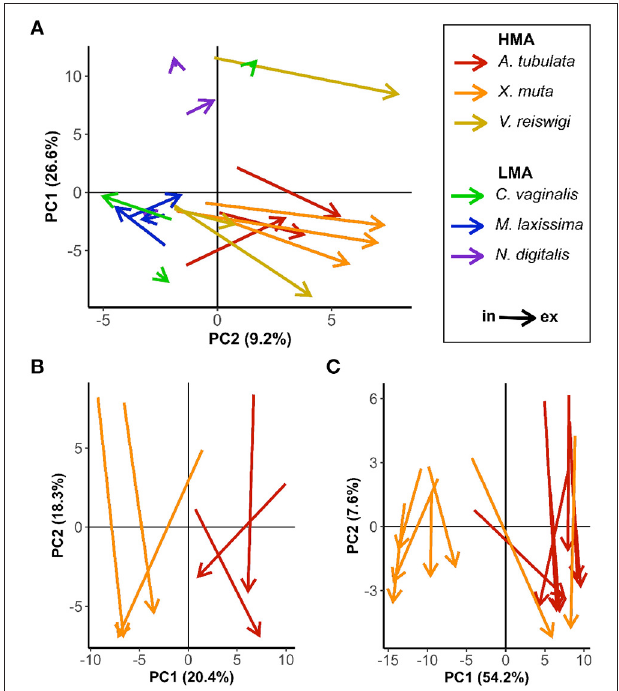
FIGURE 2 | PCA biplots of In/Ex samples. Arrows connect incurrent and excurrent samples for an individual sponge. (A) 2018 all six species; (B) 2018 A. tubulata and X. muta samples; (C) 2019 A. tubulata and X. muta samples.